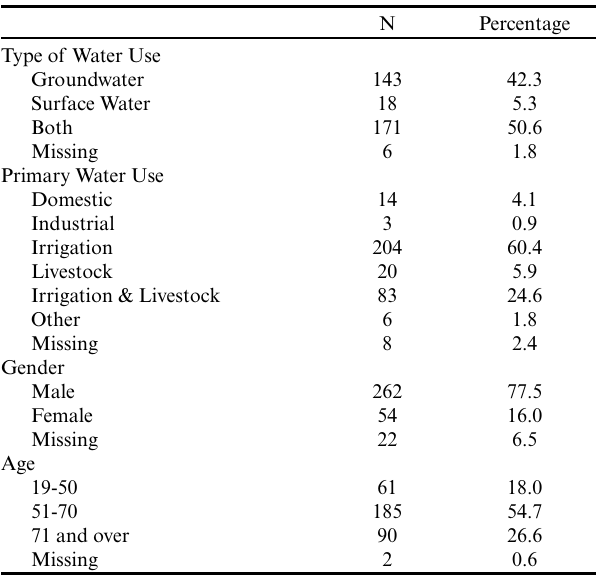
Table 4 . Water management survey demographic